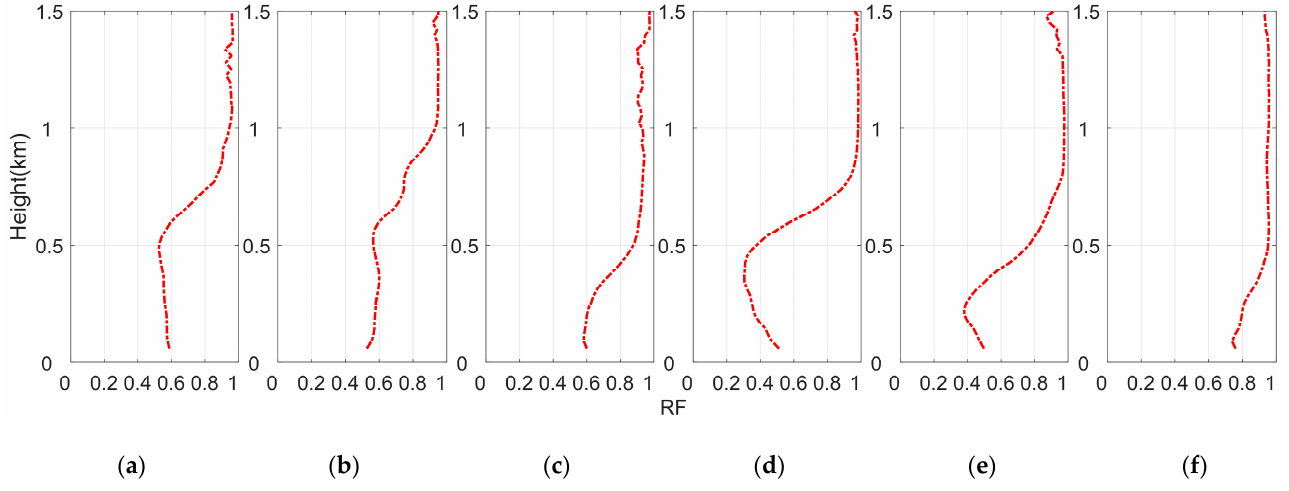
Figure 14. The recirculation factor on 25–30 September 2019. ( a ) 25 September ( b ) 26 September ( c